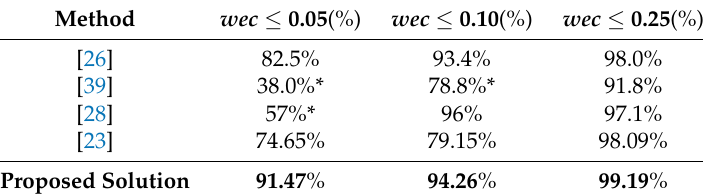
Table 5. Iris center localization results compared to other